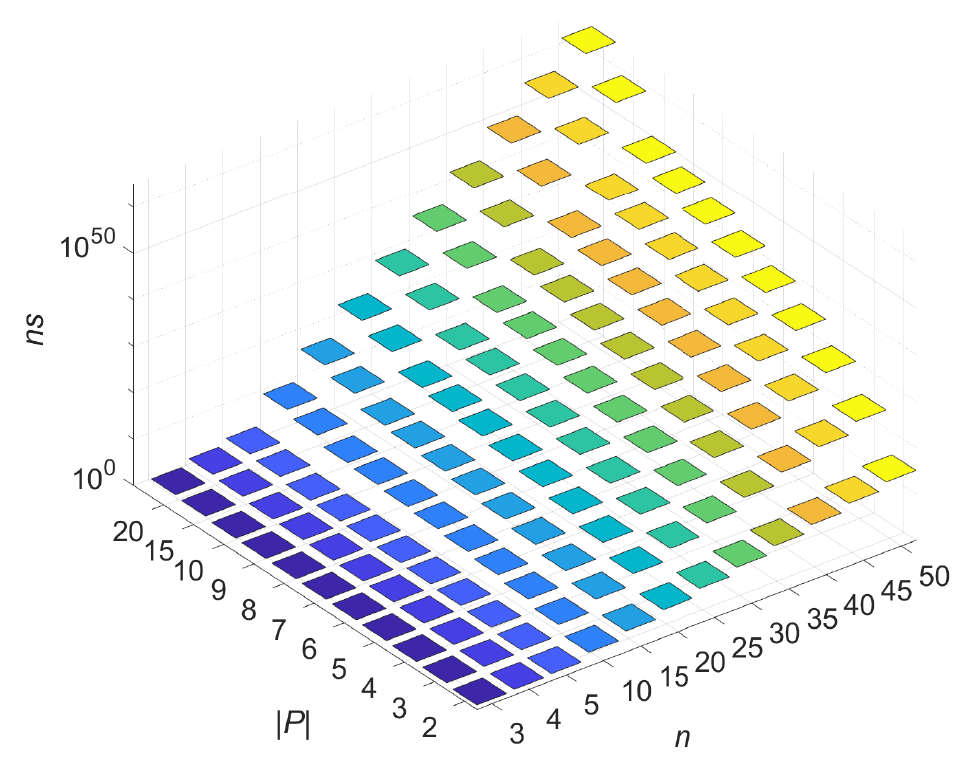
Figure 6. Determination of ns for the selected number of SA ( n ) and possible power choices | P |